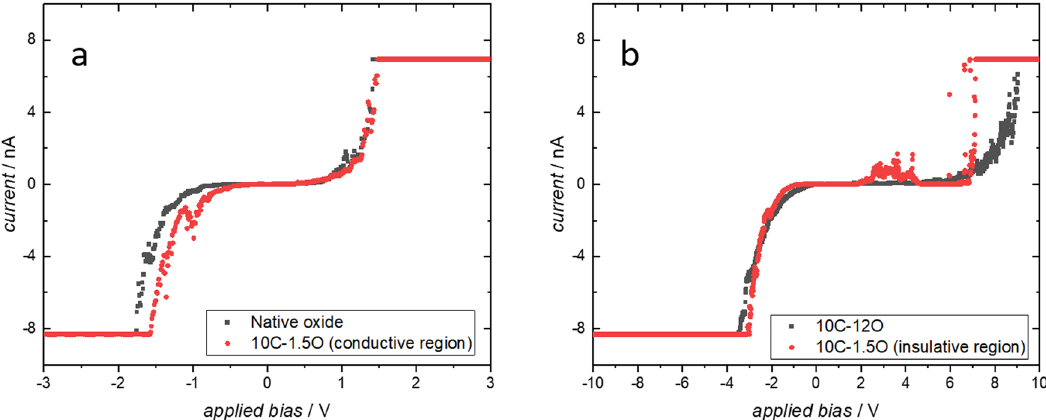
Fig. 4 Current-voltage sweeps obtained from different locations on the samples. Current – voltage sweeps obtained from the a conductive regions of the 10C-1.5O and native oxide on chromium samples and b non-conductive regions of the 10C-12O and 10C-1.5O